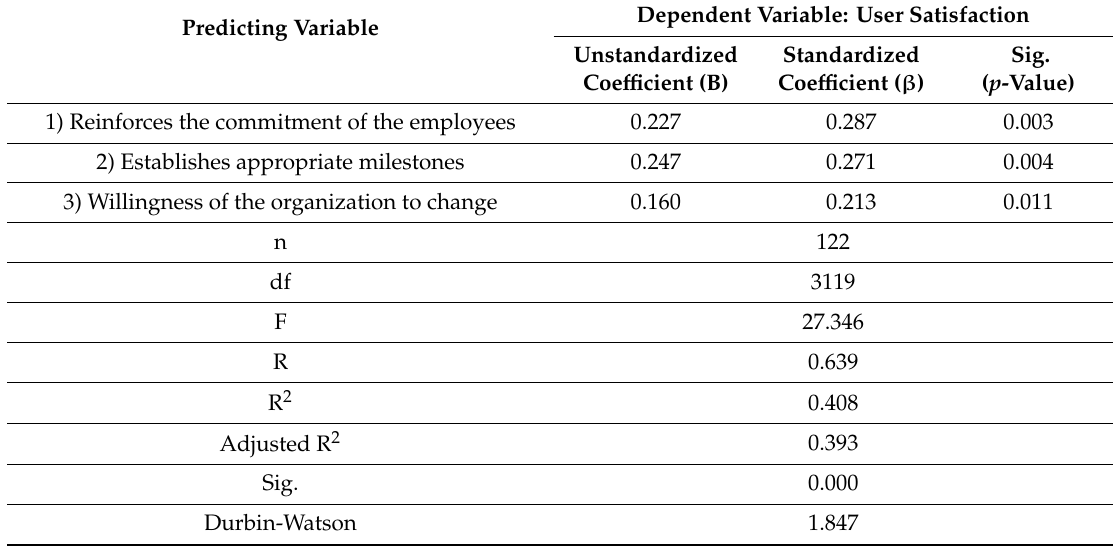
Table 3. Stepwise hierarchical regression for user satisfaction. Predicting Variable